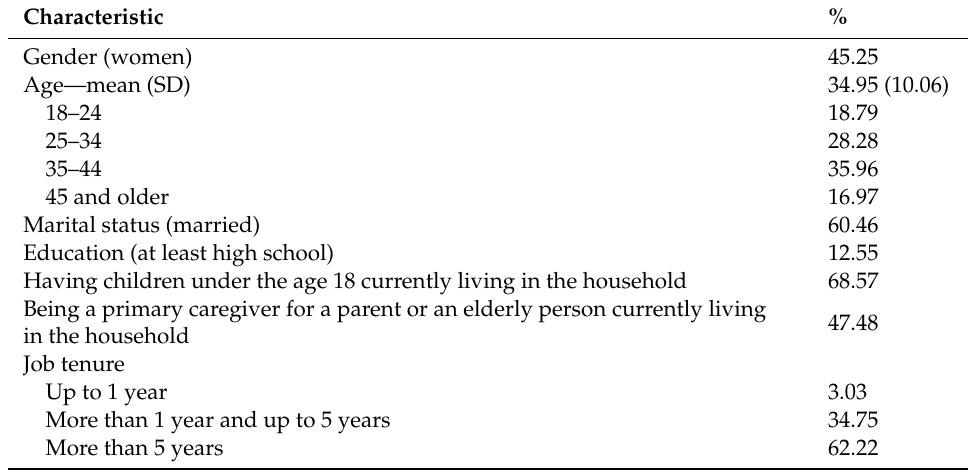
Table 1. Baseline characteristics of participants (at T = 1, n =